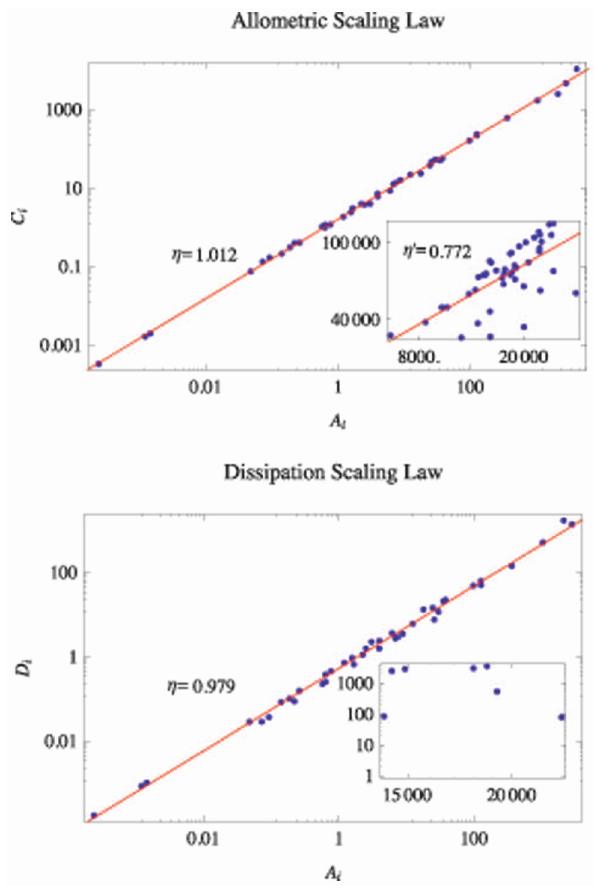
Figure 2. Allometric scaling law and dissipation law for the Mondego ecological network and the null model (insets) . Only a few points appear in the inset of the lower figure because many nodes in the null model are not balanced and their dissipation values are set to zeros.